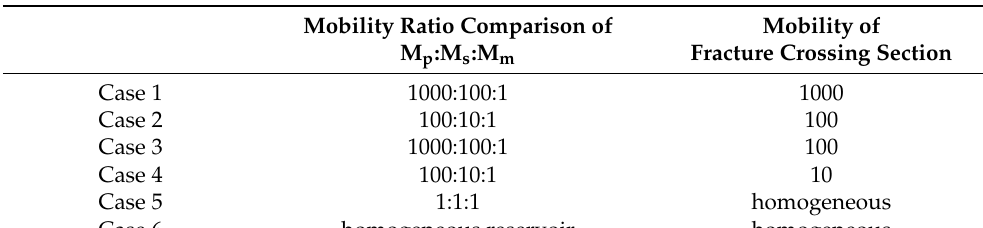
Table 1. The fracture mobility parameters for the cases based on the simplified fracture network model after Fisher et al. [36].